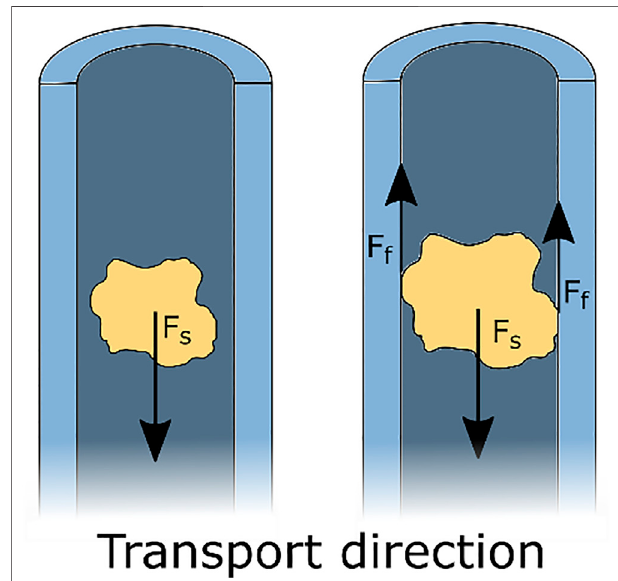
FIGURE 1 | Schematic representation of suction-based transport. A suction force F s acts on the tissue, resulting in transportation of the tissue. Clogging occurs when the piece of tissue is in contact with the walls of the tube and the resulting friction forces F f are larger than the suction force F s . Clogging prevents any further transportation of the tissue